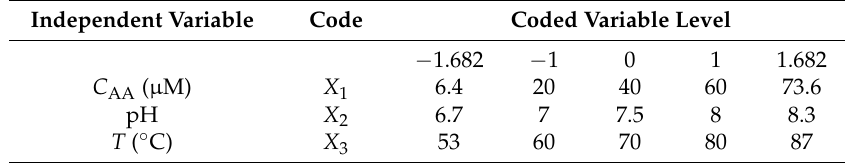
Table 1. Actual and coded values of all three independent variables considered for the experimental design.